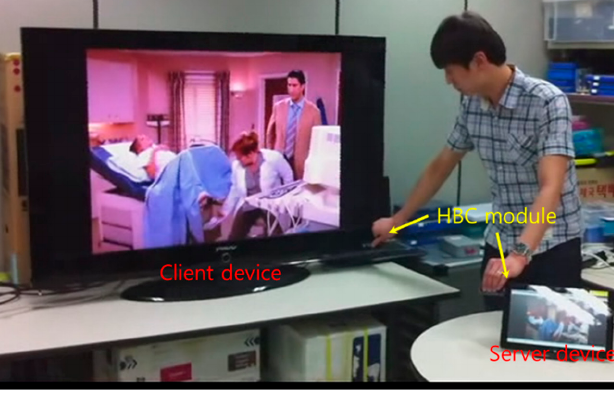
Figure 6. Scenario Flow Chart.